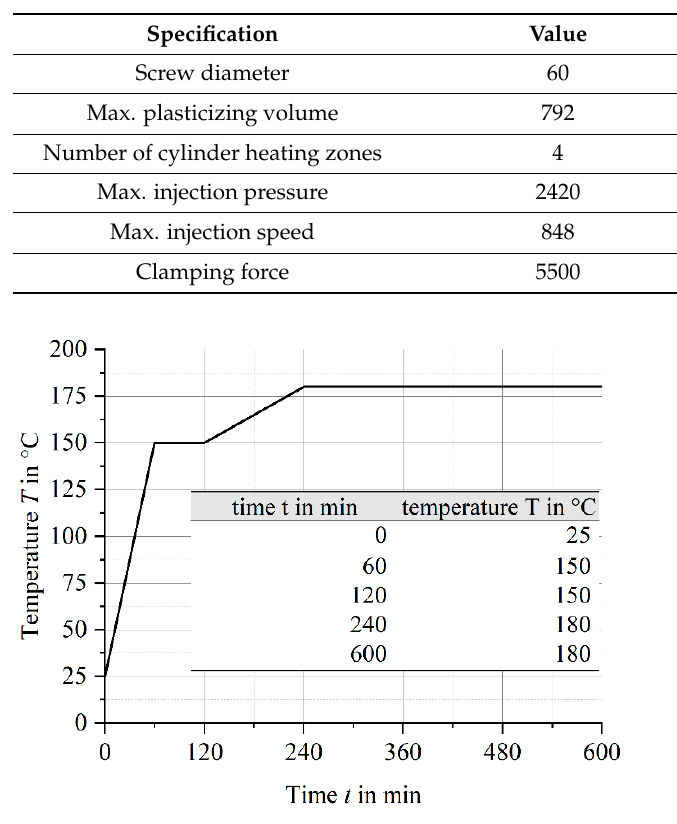
Figure 4. Post-cure cycle for molded plates.